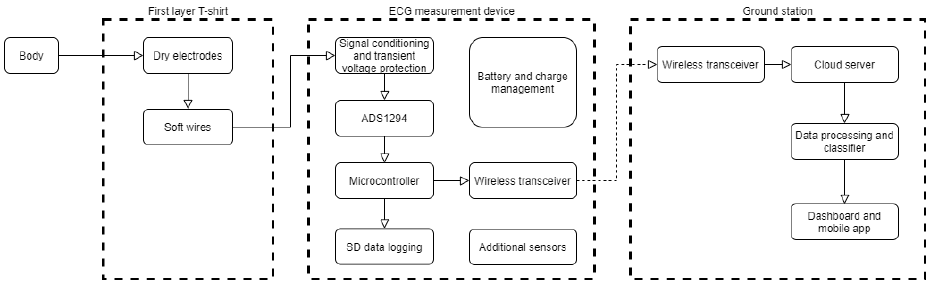
Figure 8. Monitoring system